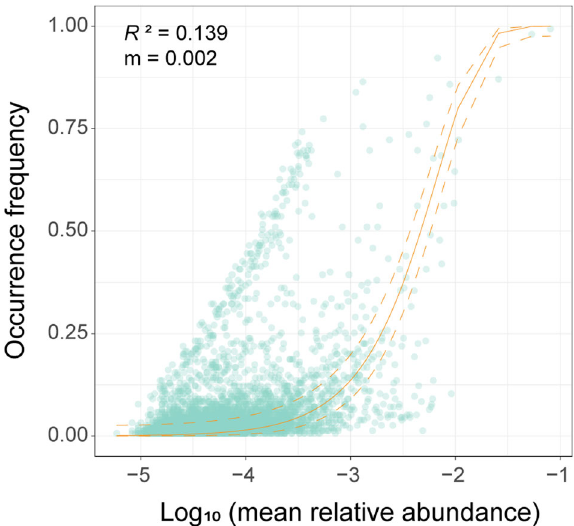
Fig. 5 Fit of a neutral model on fungal community assembly in stone fl ies. The yellow solid and dashed lines indicate the predicted occurrence and 95% con fi dence interval of the neutral model, respectively. R 2 indicates the goodness of fi t to the neutral model, and m shows the migration